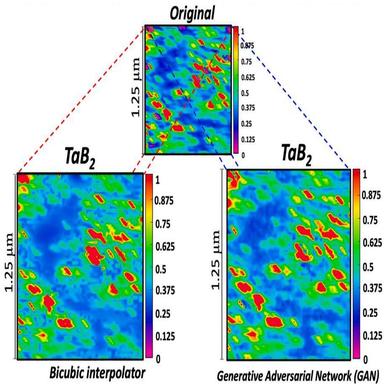
Comparison of a single slice (64 × 64) of TaB2 material normalized mapping regenerated with bicubic interpolator (left) and GAN (right).